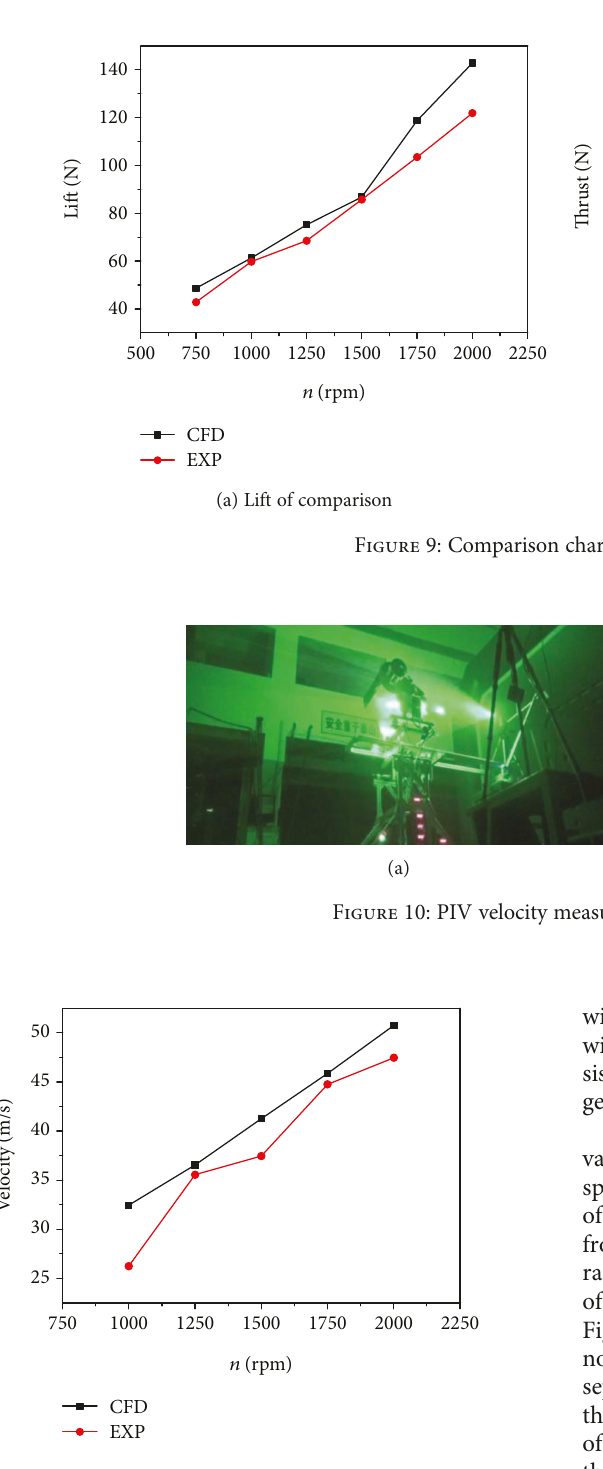
Figure 11: Comparison chart of the test and numerical value of velocity.